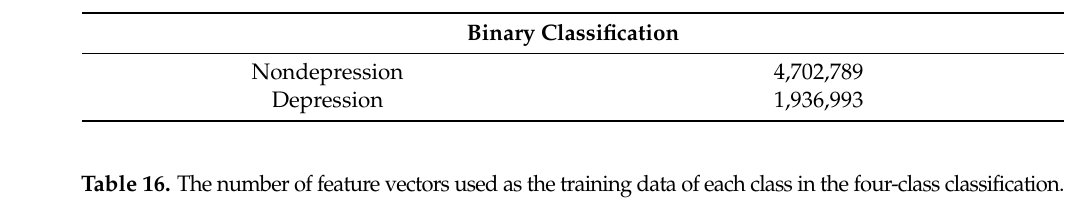
Table 15. The number of feature vectors used as the training data of each class in the binary classification.